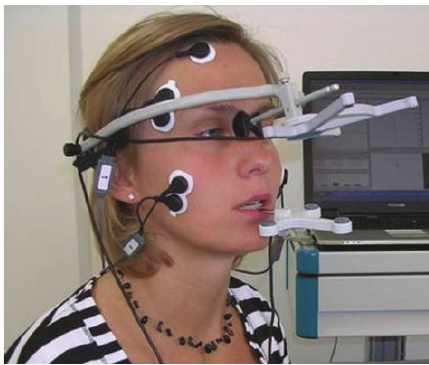
Figure 2: Jaw Motion Analysis system mounted on subject. Cour- tesy of Zebris Medical